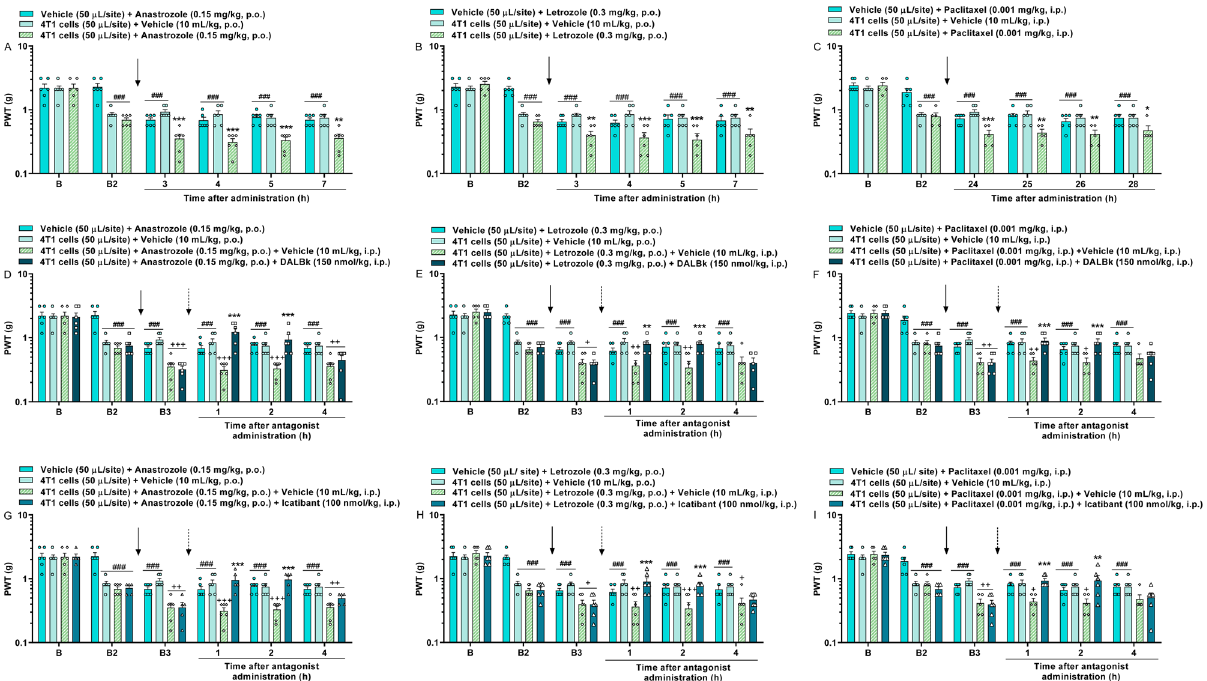
Figure 6. Anticancer drugs enhance the mechanical hypersensitivity in breast cancer-bearing mice, and kinin B 1 (DALBk, 150 nmol/kg, i.p.) or B 2 (Icatibant, 100 nmol/kg, i.p.) receptor antagonists reduce the mechanical hypersensitivity induced by breast tumor plus anticancer therapy. Time-response curves caused by the vehicle (10 mL/kg, p.o. or i.p.), anastrozole (0.15 mg/kg, p.o.; A ), letrozole (0.3 mg/kg, p.o.; B ) or paclitaxel (0.001 mg/ kg, i.p.; C ) administration at 10 days after vehicle (50 µL/site) or 4T1 breast cancer cells (10 4 cells, 50 µL/site) injection. Time-response curves caused by the vehicle, DALBk ( D – F ) or Icatibant ( G – I ) treatment in animals previously injected with 4T1 breast cancer cells (10 4 cells, 50 µL/site) plus anastrozole (0.15 mg/kg, p.o.; D;G), letrozole (0.3 mg/kg, p.o.;E;H) or paclitaxel (0.001 mg/kg, i.p.;F;I). (B) Denotes the baseline mechanical threshold before cells injection and drugs administration. (B2) denotes the baseline mechanical threshold at 10 days after cells injection and before drugs administration. (B3) denotes the baseline mechanical threshold at 10 days after cells injection and 3 h after anastrozole or letrozole administration, or 24 h after paclitaxel administration. The closed arrows indicate the timing of anticancer therapy administration, and the dotted arrows indicate timings of antagonist administration. Data are expressed as the mean + SEM (n = 5–6/group; BALB/c mice). ### P < 0.001 when compared to the baseline (B); + P < 0.05 when compared to the 4T1 cells plus vehicle group; *P < 0.05; **P < 0.01; ***P < 0.001 when compared 4T1 cells plus anastrozole, letrozole or paclitaxel group; two-way repeated-measures ANOVA followed by Bonferroni’s post hoc test. PWT paw withdrawal